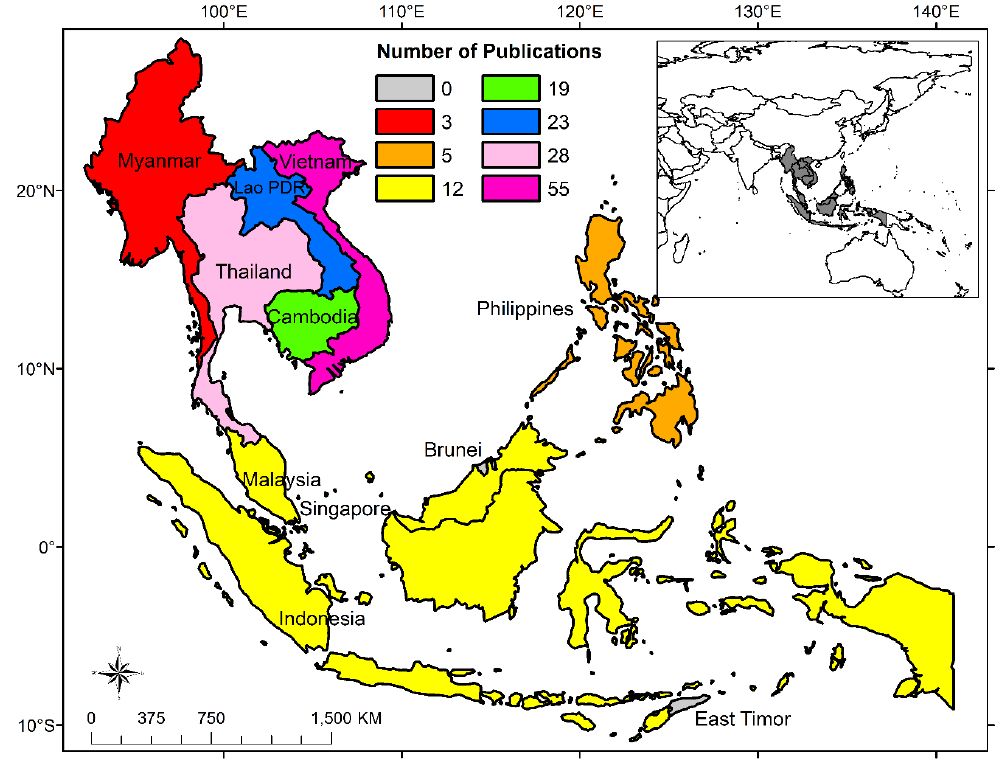
Figure 1. Number of SWAT studies in Southeast Asia (the totals for each country include transnational studies that were performed for multiple countries).